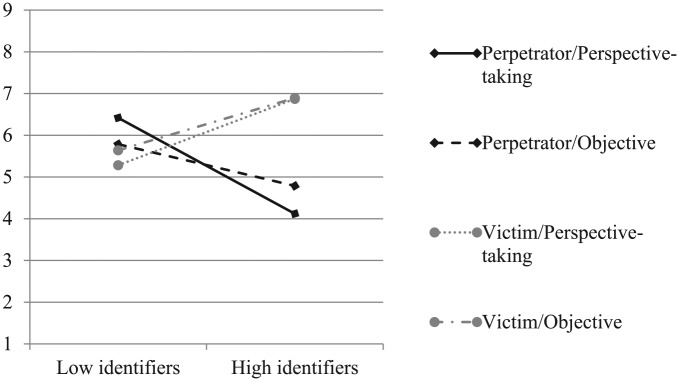
Support for retributive justice as a function of ingroup’s role (perpetrator vs. victim), perspective-taking with perpetrators (perspective-taking vs. objective), and national identification (Study 3).